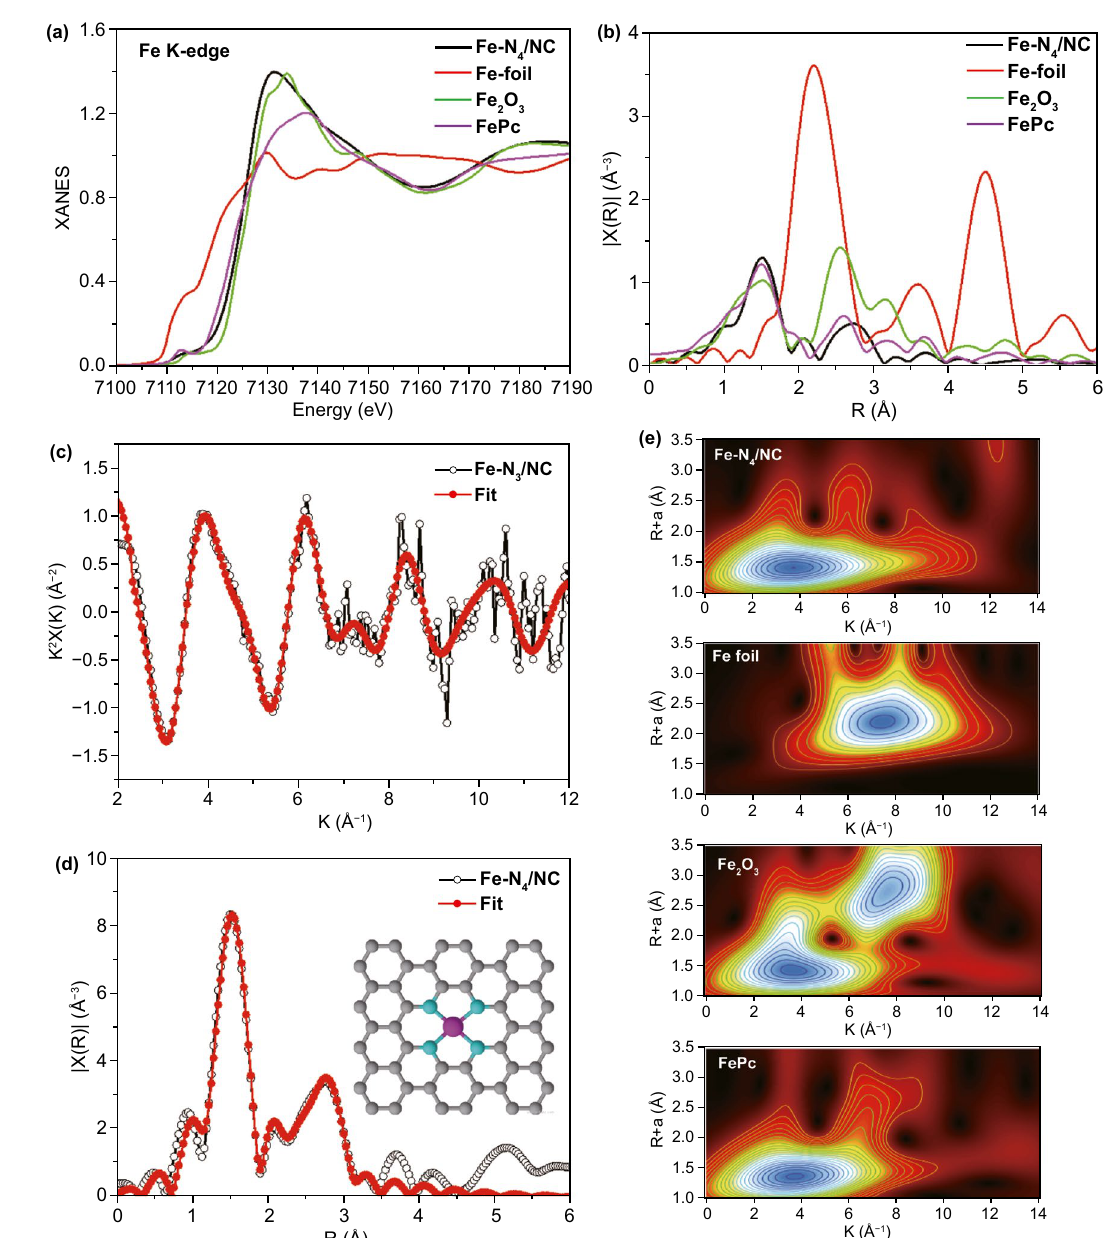
Fig. 5 The local electronic state and chemical environment of Fe-N 4 /NC. a Comparison of Fe K-edge XANES spectra of Fe foil, Fe 2 O 3 , FePc, and Fe-N 4 /NC. b Fourier transform of the EXAFS spectra of Fe foil, Fe 2 O 3 , FePc, and Fe-N 4 /NC. c , d EXAFS analysis of Fe-N 4 /NC at K and R space, respectively. The inset in d demonstrates the model derived from the EXAFS results. e Wavelet transform of Fe K-edge XANES spectra of Fe foil, Fe 2 O 3 , FePc, and Fe-N 4